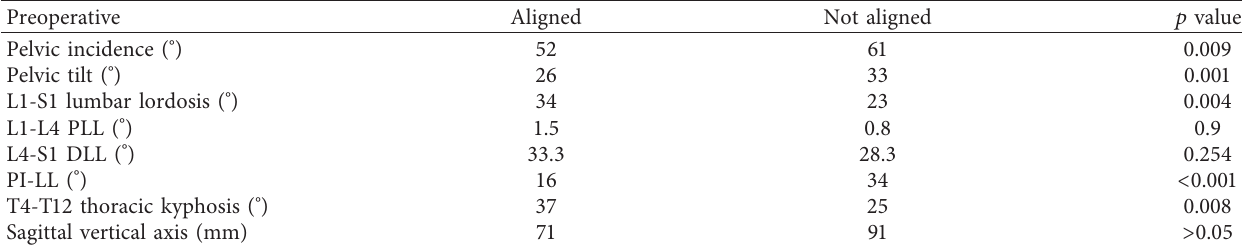
Table 1: Preoperative values of radiographic parameters between “aligned” and “not aligned” groups.